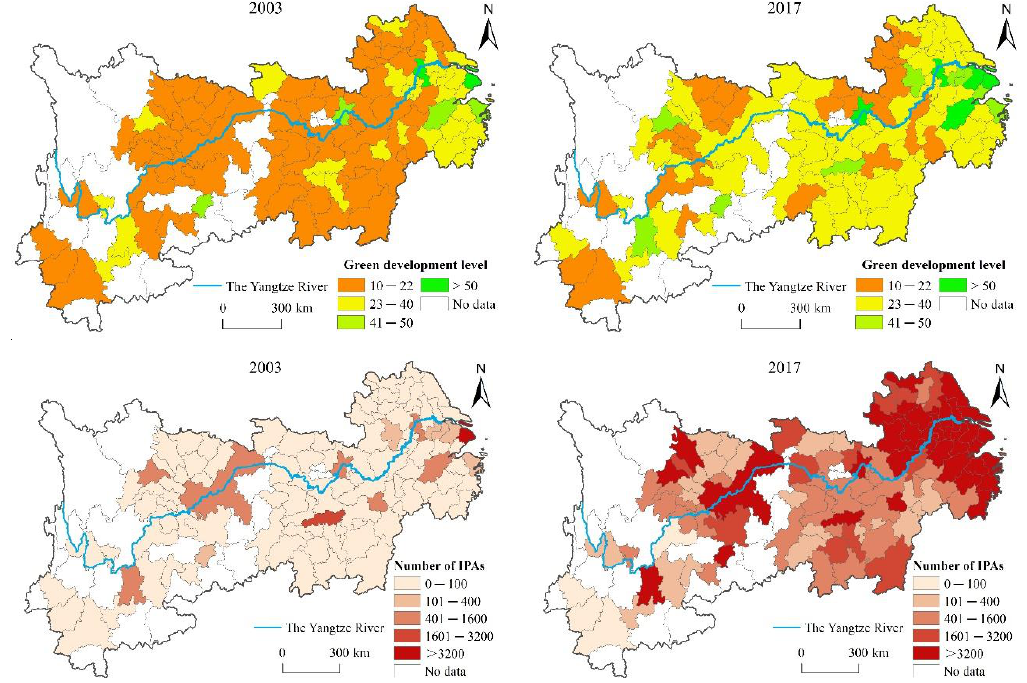
Figure 4. Spatio-temporal pattern of technological innovation and green development in the YREB in 2003, 2017. IPAs: invention patent applications